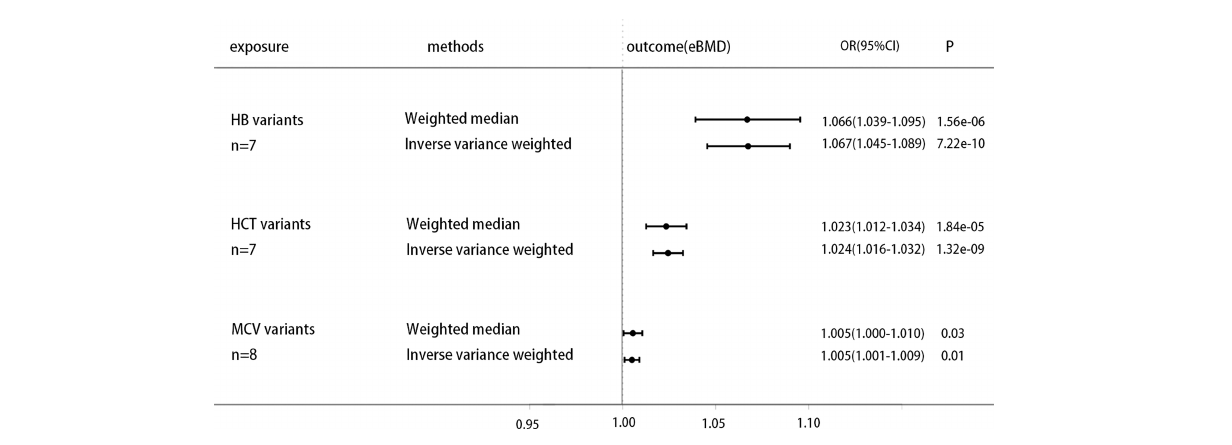
Frontiers in Endocrinology |